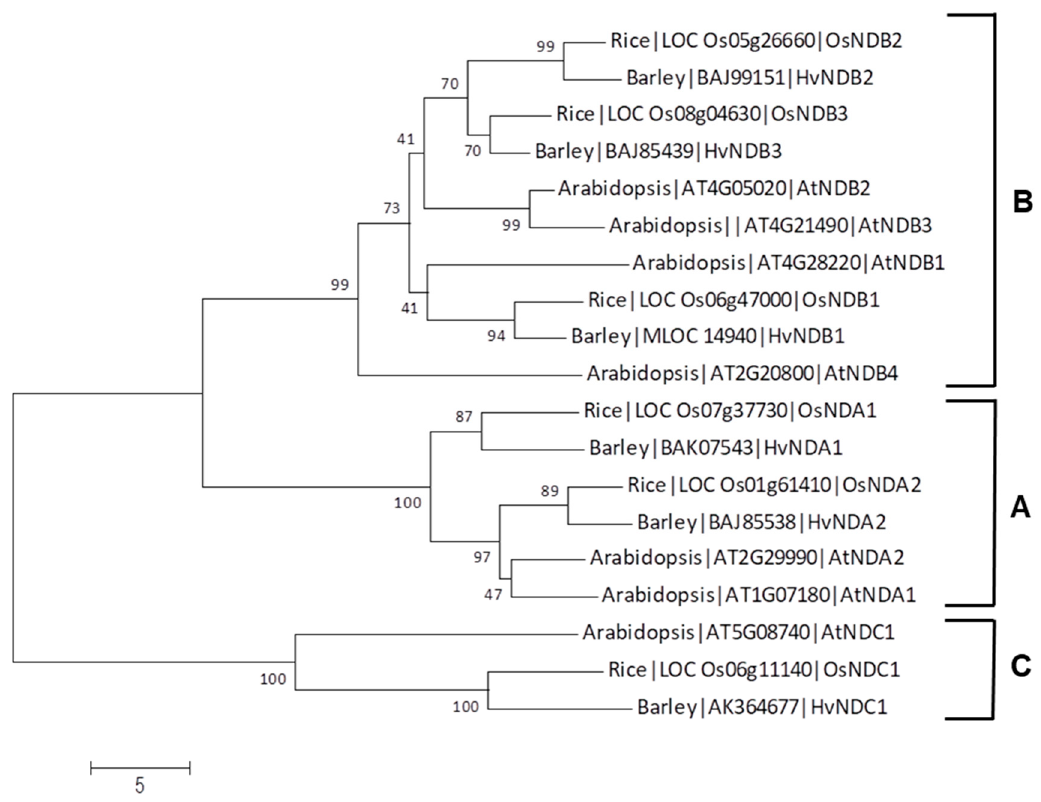
Figure 3. Relationship tree that shows the sequence homology of alternative dehydrogenases from rice, barley and Arabidopsis. Clades A, B and C correspond to NDA, NDB and NBC, respectively. The tree was constructed using the Neighbour-Joining method in MEGA 7. Numbers at each node are the percentage bootstrap values of 1000 replicates. The scale bar indicates the number of amino acid substitutions at each